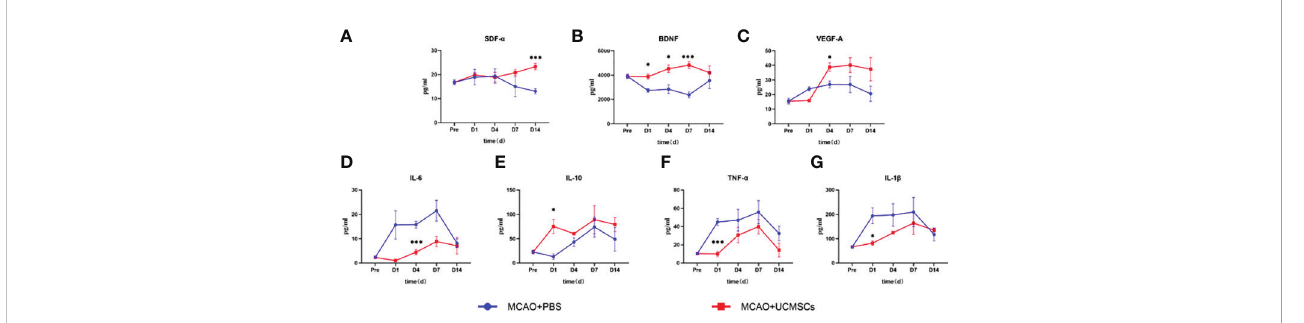
FIGURE 3 Cytokine levels in serum samples of MCAO rats after administration of hUCMSCs. (A – G) Expression levels of SDF- a , BDNF, VEGF-A, IL-6, IL-10, TNF- a , and IL-1 b in serum, respectively. Data are presented as mean ± SD. Statistically signi fi cant values between the treatment and the model groups are denoted as *P < 0.05, and ***P <